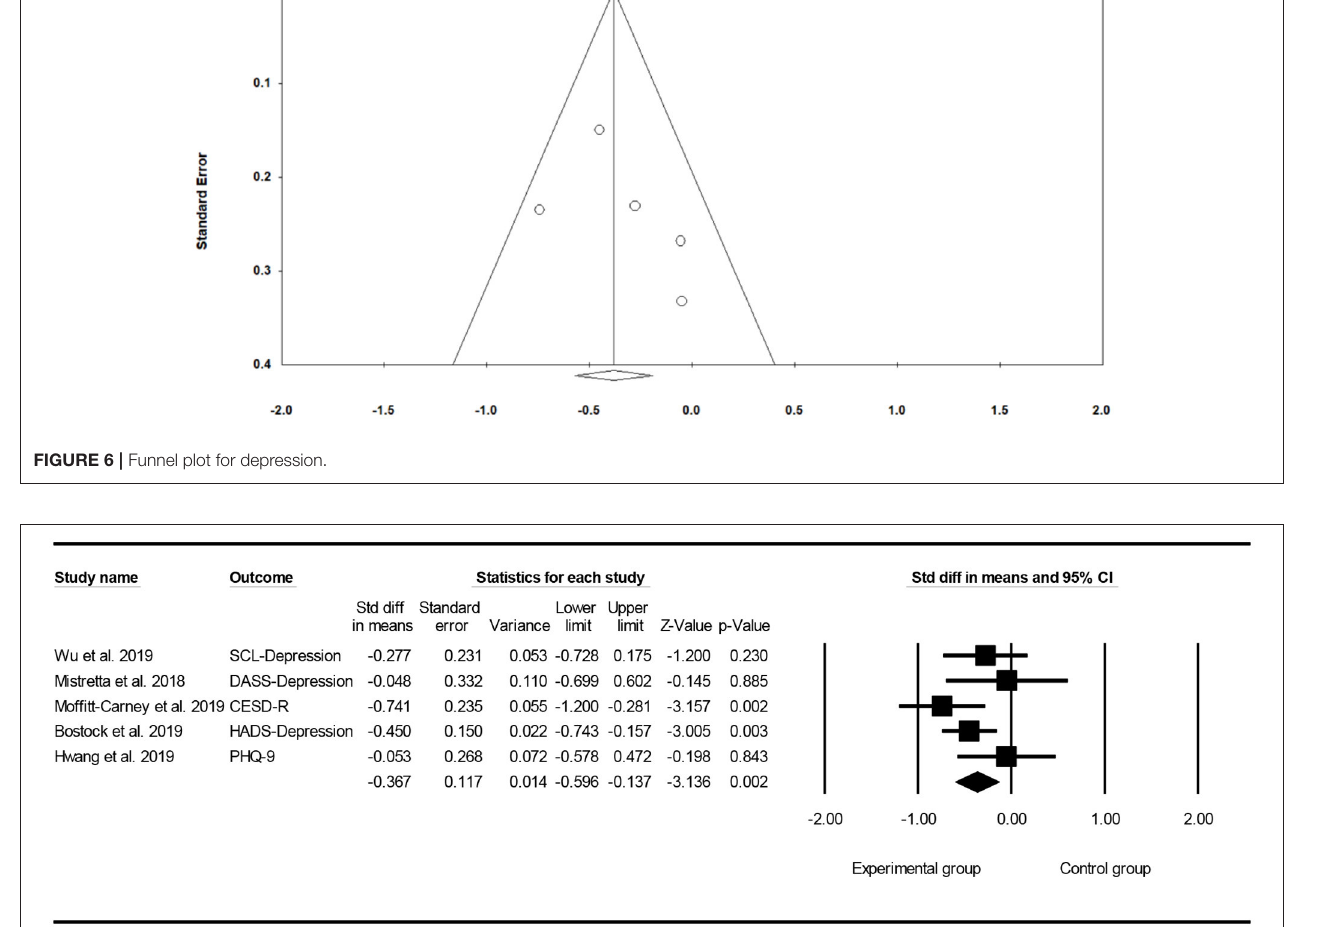
FIGURE 7 | Forest plot for